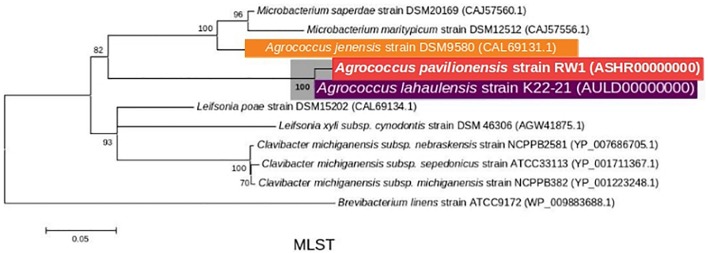
Maximum-Likelihood tree based on MLST analysis (∼2939 amino acid) showing the phylogenetic relationship among the different isolates of the genus Agrococcus and deeper relatives of the Microbacteriaceae. Bootstrap values greater than 50% are given at nodes. Bar represents a nucleotide substitution rate per 100 nucleotides.